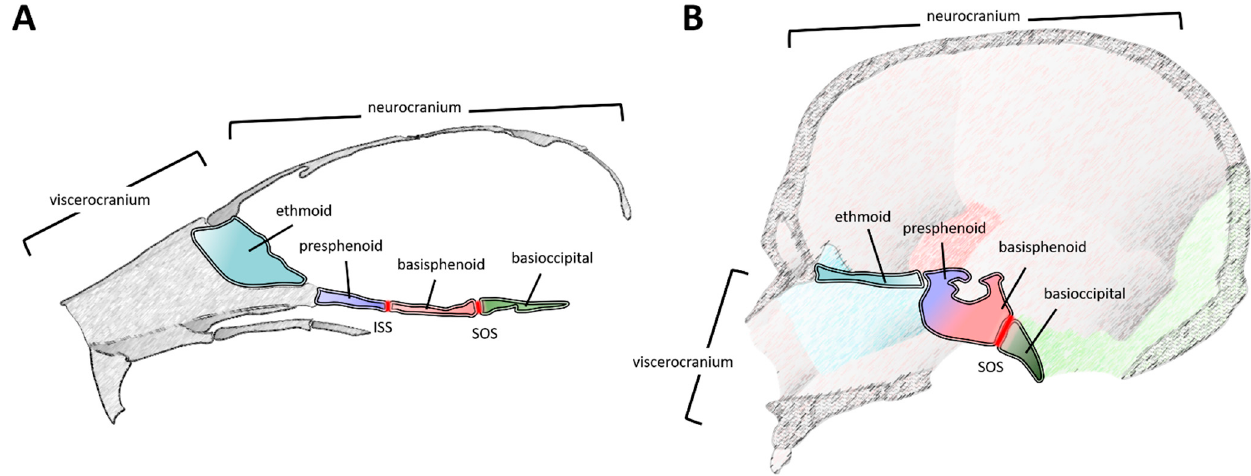
Figure 2. Schematics illustrating a midsagittal plane of the cranial base, in relation to other cranial structures, in a mouse ( A ) and a human ( B ). Note, scales are not equivalent. The major elements within this plane are the ethmoid (teal), presphenoid (light blue), basisphenoid (light red), and basioccipital (green). Major growth zones (synchondroses) are highlighted (dark red), including the inter-sphenoid and spheno-occipital synchondrosis. Note, in panel B, the presphenoid and basisphenoid have fused into the sphenoid (gradient of light blue and red), so the inter-sphenoid synchondrosis is not demarcated. The relative units of the skull, including the neurocranium (calvaria and the cranial base) and the viscerocranium (facial bones) are denoted. Rostral is to the left and caudal is to the right. The lower jaw (mandible) is not depicted. Abbreviations: ISS, inter-sphenoid synchondrosis; SOS, spheno-occipital